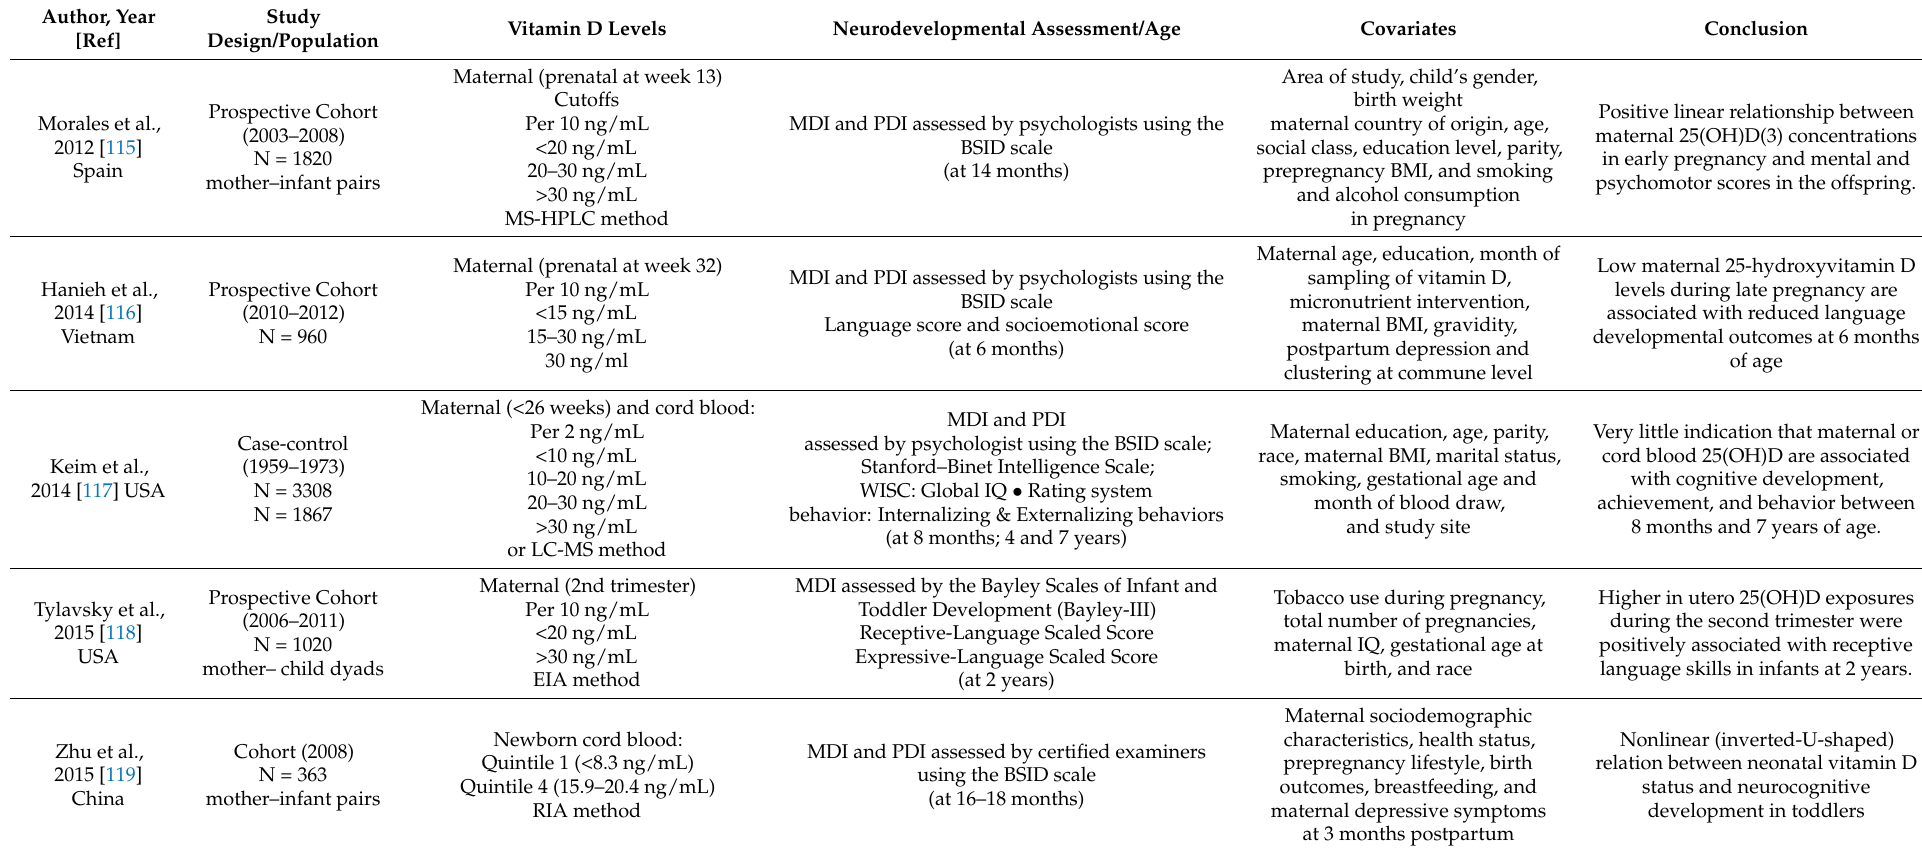
Table 1. Prospective studies on associations between prenatal vitamin D status and